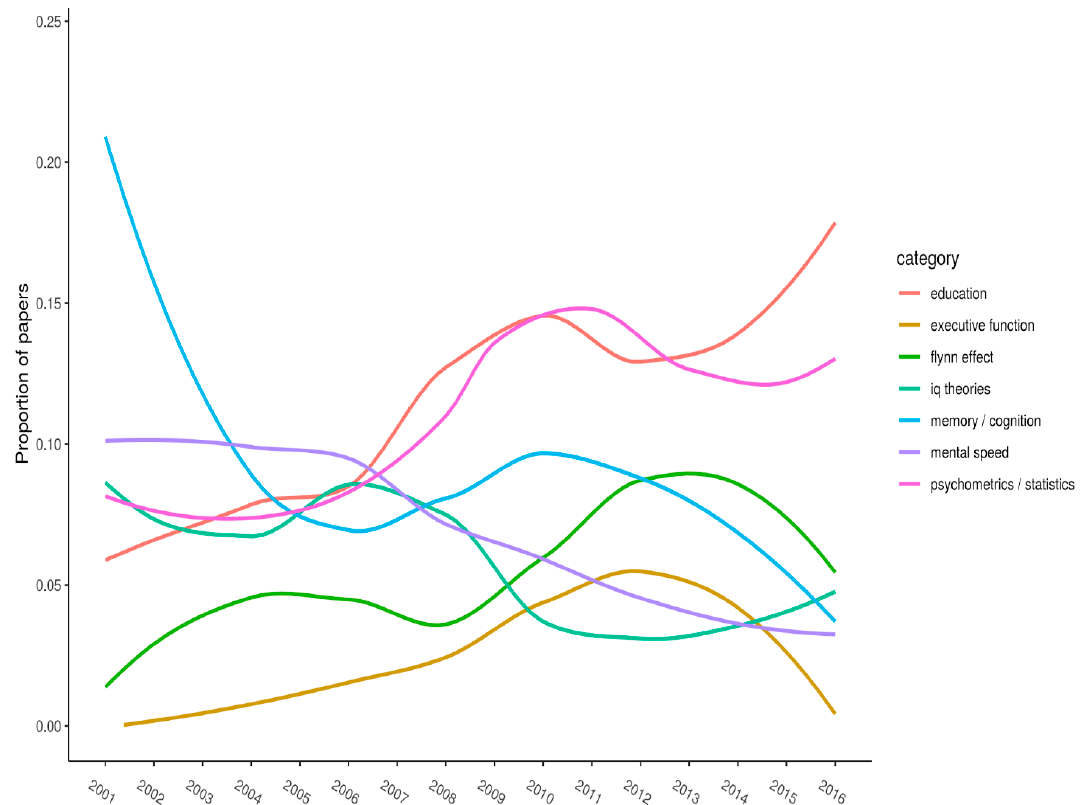
Figure 2. Proportion of articles each year that list a given keyword (parabolic). J. Intell. 2018 , 6 , x FOR PEER REVIEW